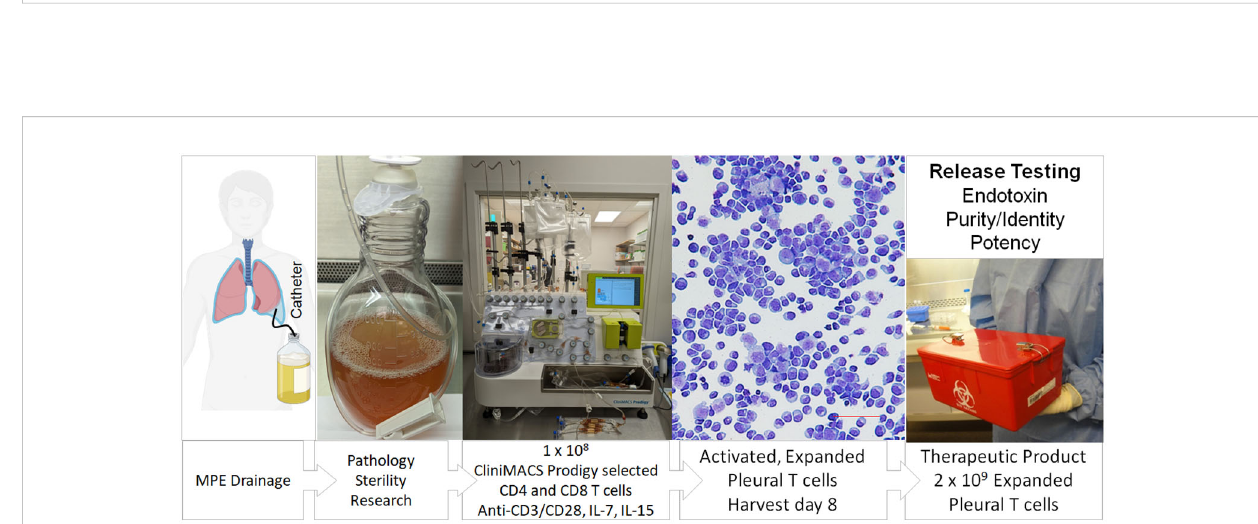
FIGURE 6 Schema for production of a cellular therapeutic from pleural in fi ltrating T cells. Patients routinely drain effusions into a sterile vessel using a Pleurex catheter. T cells in the pleural fl uid are quanti fi ed by fl ow cytometry and loaded onto the Miltenyi CliniMACS Prodigy, a closed system instrument capable of cell selection and expansion. CD4+ and CD8+ cells are puri fi ed by immunomagnetic selection; other cells, including tumor cells are excluded. A volume of selected cells containing 1 x 10 8 T cells are transferred to a temperature and CO 2 controlled chamber where they are activated with CD3/CD28 beads and cultured in the presence of IL-7 and IL-15. Eight days later, activated, expanded pleural T cells, which have undergone a 20 to 50-fold expansion, are harvested. In future clinical trials, cells will be tested for endotoxin, activated T cell content (identity), absence of tumor cells (purity) and cytokine secretion (potency) prior to release as a cellular